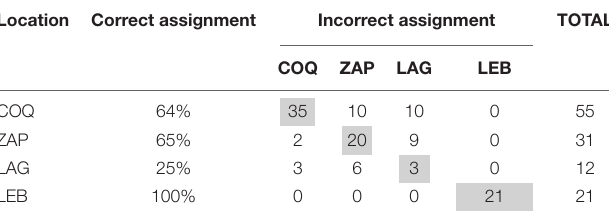
TABLE 6 | Assignment performance of the heterologous microsatellite markers studied. Location Correct